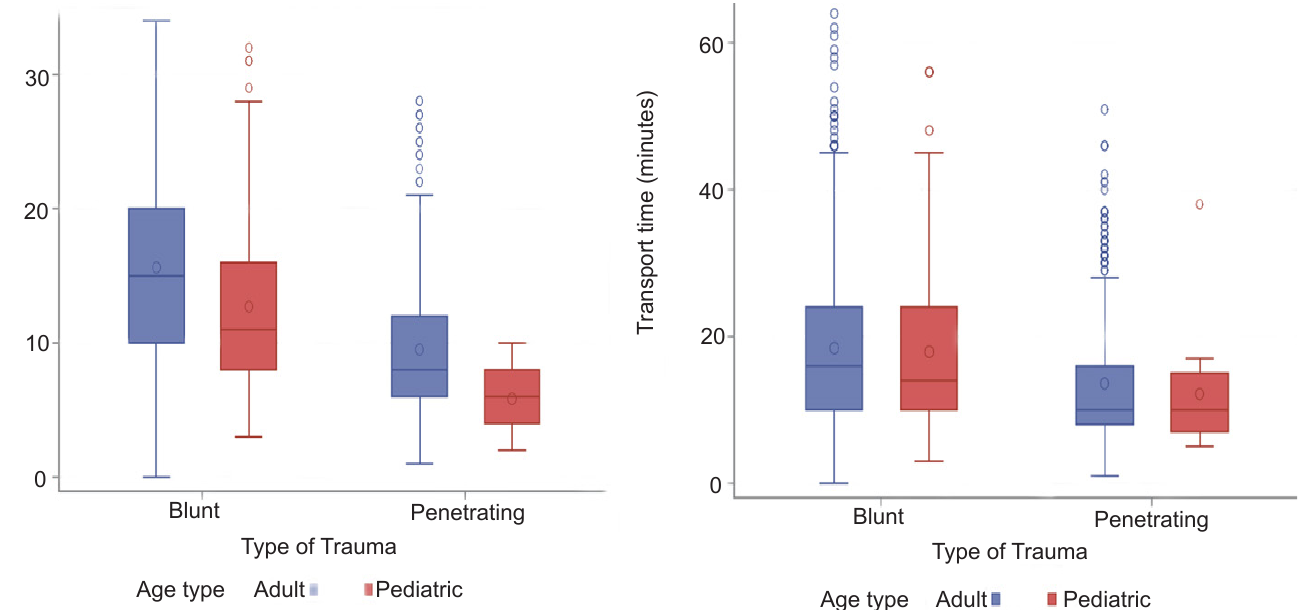
Figure 2. Box plots displaying scene time and transport time by mechanism of injury and age.